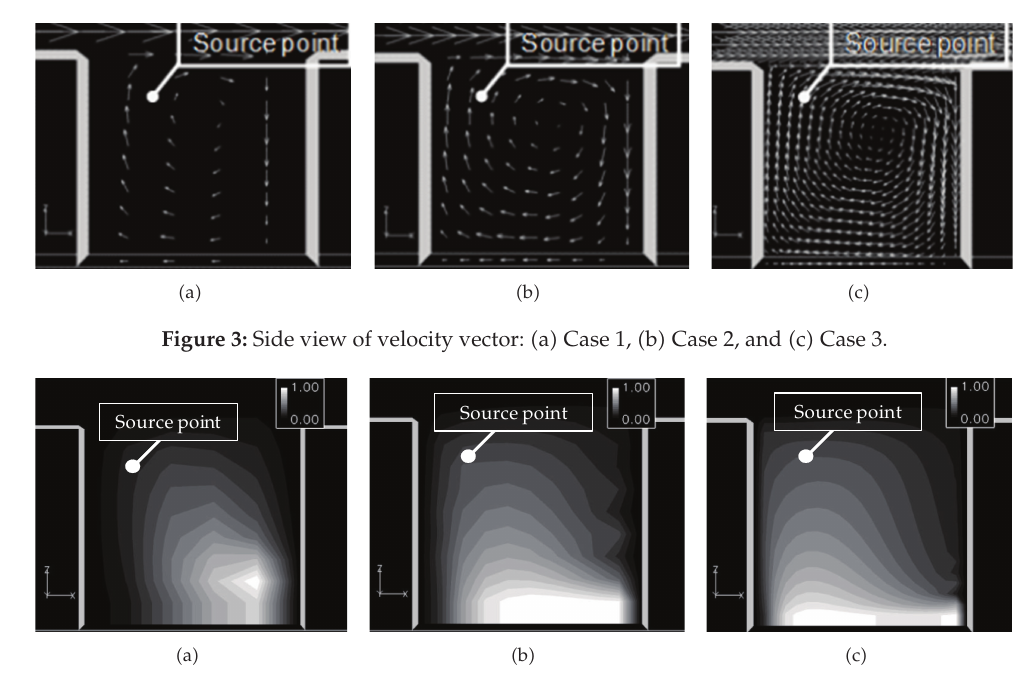
Figure 4: Input conditions for reverse simulation (cid:3) tU b /H b (cid:7) 100 (cid:4) : (cid:3) a (cid:4) Case 1, (cid:3) b (cid:4) Case 2, and (cid:3) c (cid:4) Case